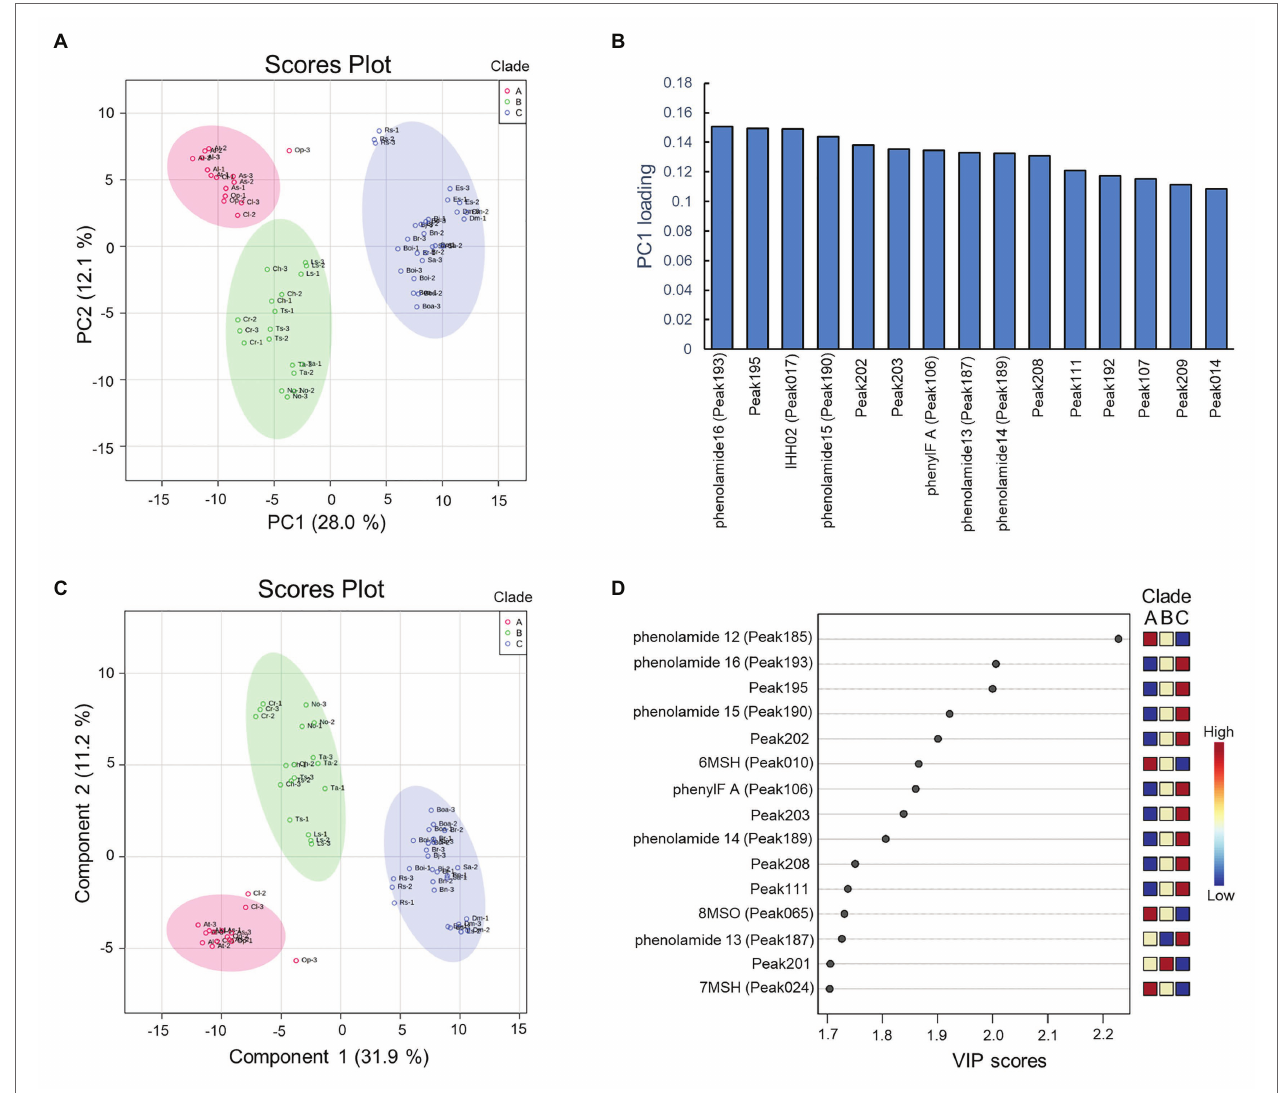
FIGURE 4 | Results of principal component analysis (PCA) and partial least squares-discriminant analysis (PLS-DA) of the metabolite data. (A) PCA scores plot between the principal component 1 (PC1) and PC2. The explained variances are shown in brackets, colors of circle indicate three replications of metabolite data of species; (B) PCA loading plots between the PC1 and PC2; (C) PLS-DA scores plot between the PC1 and PC2. The explained variances are shown in brackets; (D) Important features identified by variable importance in projection (VIP) scores. The colored boxes on the right indicate the relative concentrations of the corresponding metabolite in each